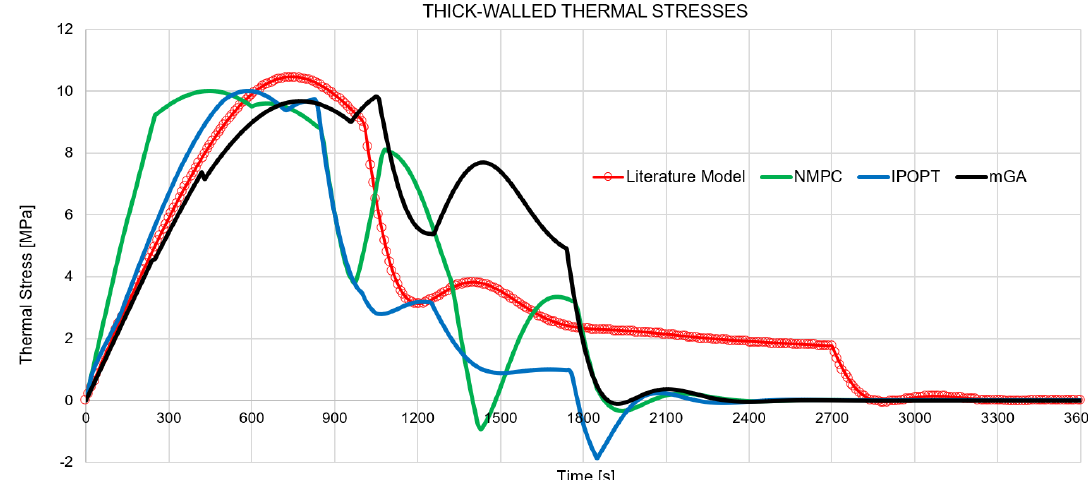
Figure 20. Results comparison between the curves of the operating reference profile available in the literature (red line), the optimized profiles reported by [17] (green line) and [20] (blue line), and the proposed approach (black line) for the thick-walled von Mises stresses.